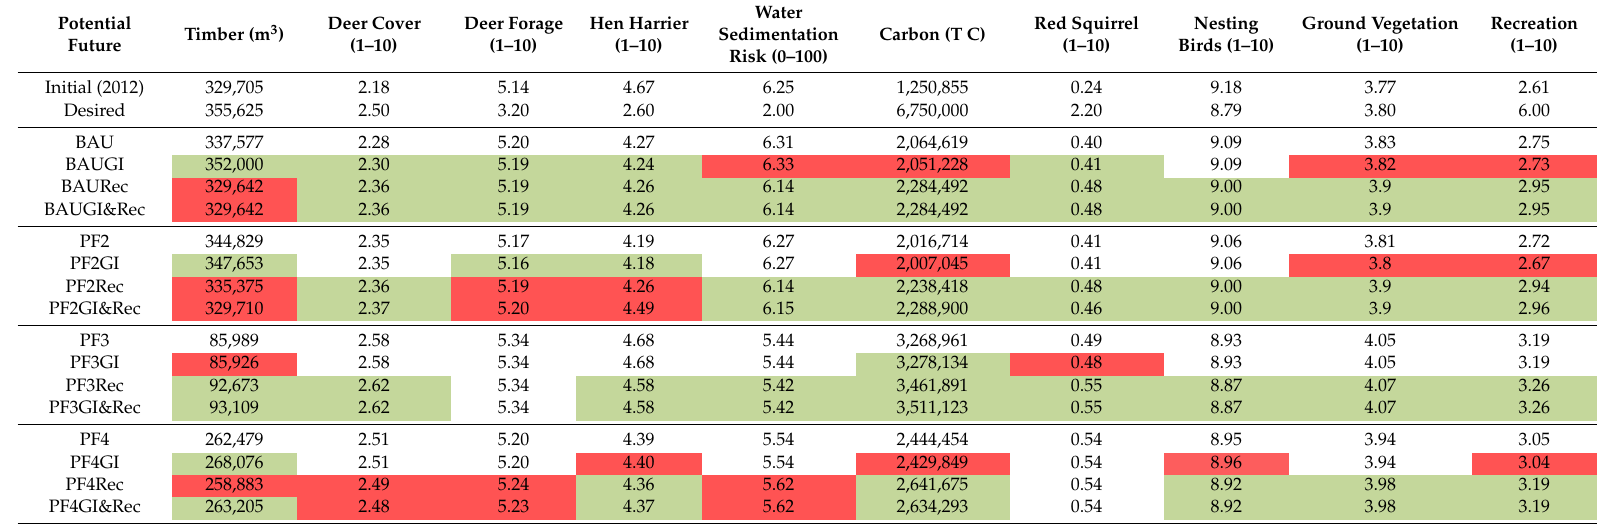
Table 10. Summary of the ES outputs (average values for the years 2012 to 2082) for all backcasting policies assessed for robustness in the NM CSA. The red cells highlight the ESs that, compared to their level in the PF, move away from the stakeholder desired endpoint when the backcasting policies are implemented; the green cells highlight a move towards the stakeholder desired endpoint; while the ESs in the cells with no shading are unchanged from those for the